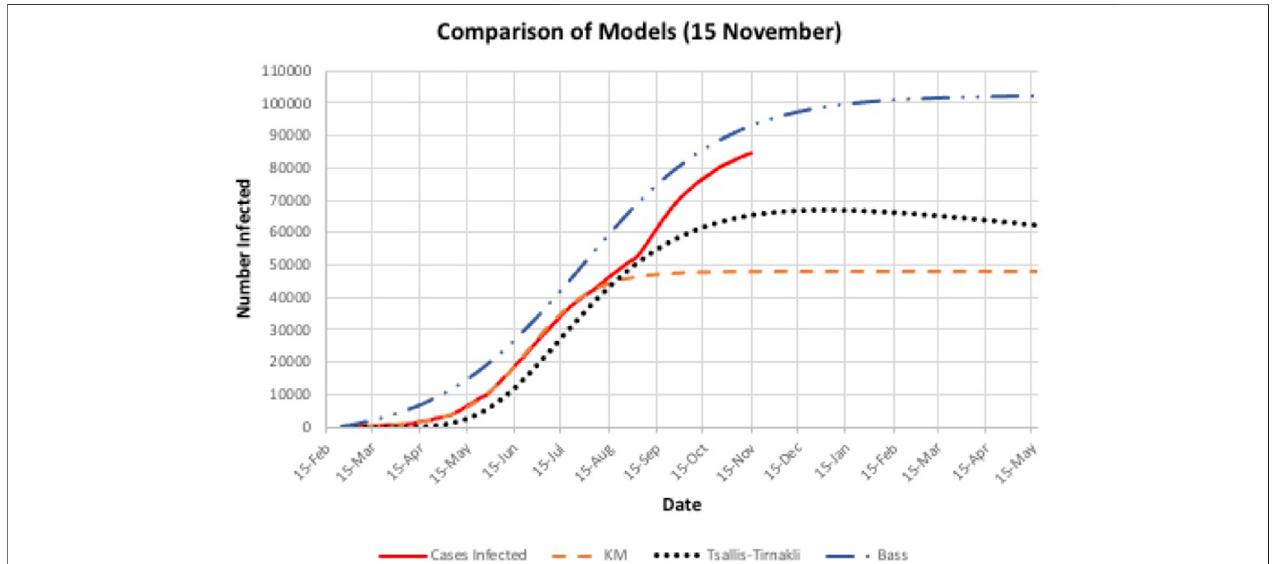
FIGURE 4 | All three Bahrain models failed to detect the second wave on September 3rd.